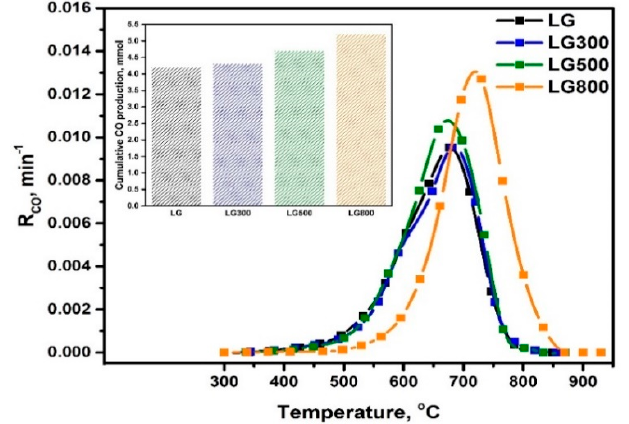
Figure 7. Effect of temperature on the instant CO production rate, R CO , and the cumulative CO production (inset) for raw lignite and chars during non-isothermal CO 2 gasification. Fuel: 100 mg, Flowrate: 30 cm 3 /min.